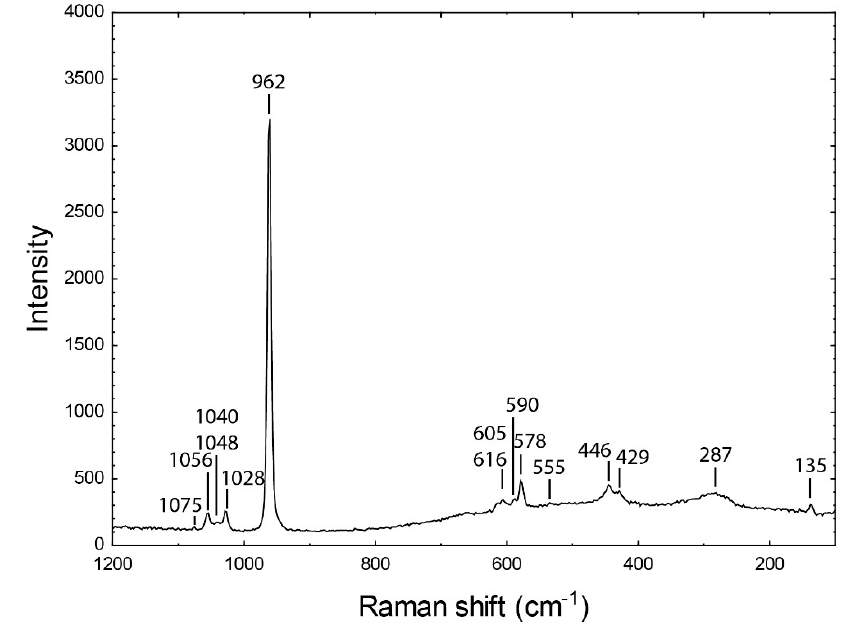
Figure 8. Raman spectrum of hydroxylapatite from Muránska Dlhá Lúka measured with blue laser. Table 5. Raman spectrum band assignment of hydroxylapatite from Muránska Dlhá Lúka.